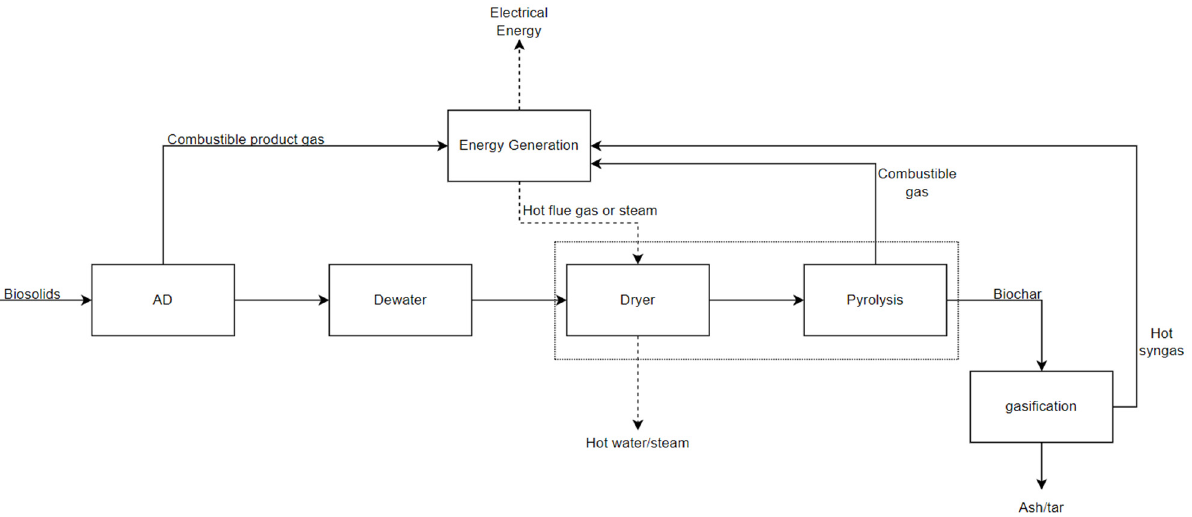
Figure 3. Generic BFD of a combined dryer and thermal treatment system. The dryer and pyrolysis units may be separated or combined into a single system. Various energy-rich gas streams are iden- tified and utilized in an energy generation system that feeds the dryer.